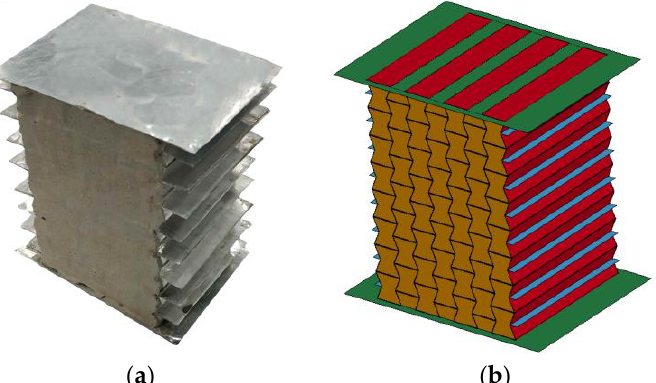
Figure 8. The auxetic honeycomb filled with foam concrete: ( a ) photo; ( b ) numerical model.